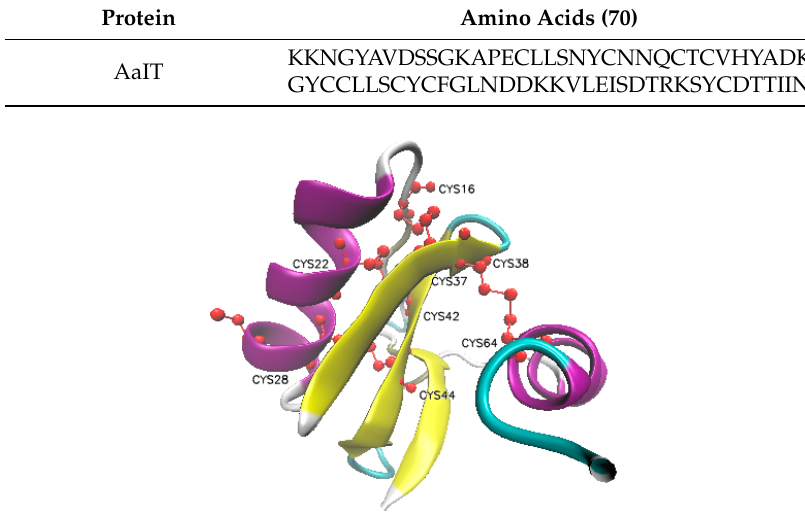
Figure 1. Structure of AaIT protein.